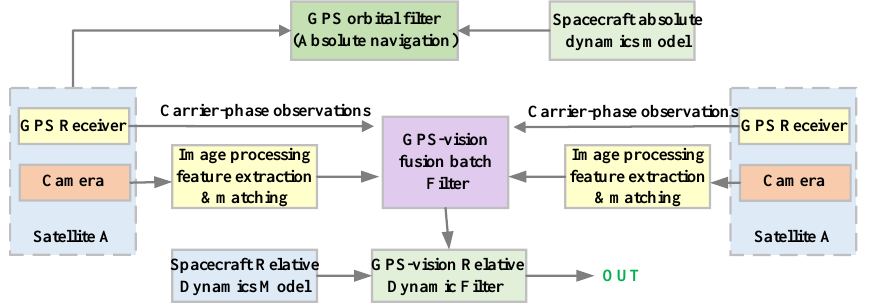
Figure 24. Schematic diagram of GPS + visual combined relative state measurement.